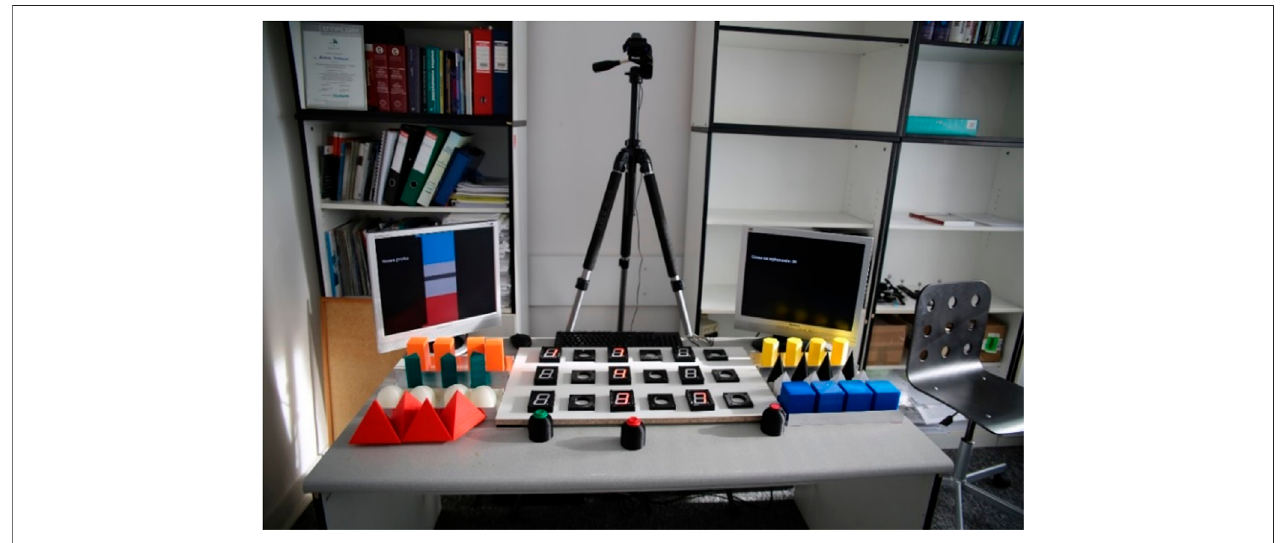
FIGURE1| Samplesetupofthetask.Objectmatrixinthecenter.Monitoronleftdisplaysthesecondarytask,monitoronrighttheremainingtimeorobjectmapping on request. The button on left corrects secondary task position, middle button ends/begins the trial, and right button displays object-slot mapping.